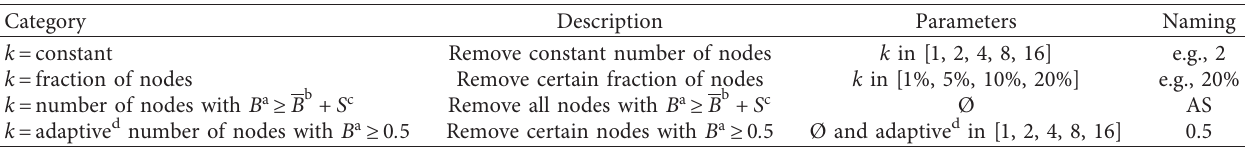
Figure 3: Distribution of betweenness values of sample network in Figure 1. (a) GCC of I2. (b) GCC of I3. (c) GCC of I4. (d) GCC of IR. Table 1: Overview of k settings.